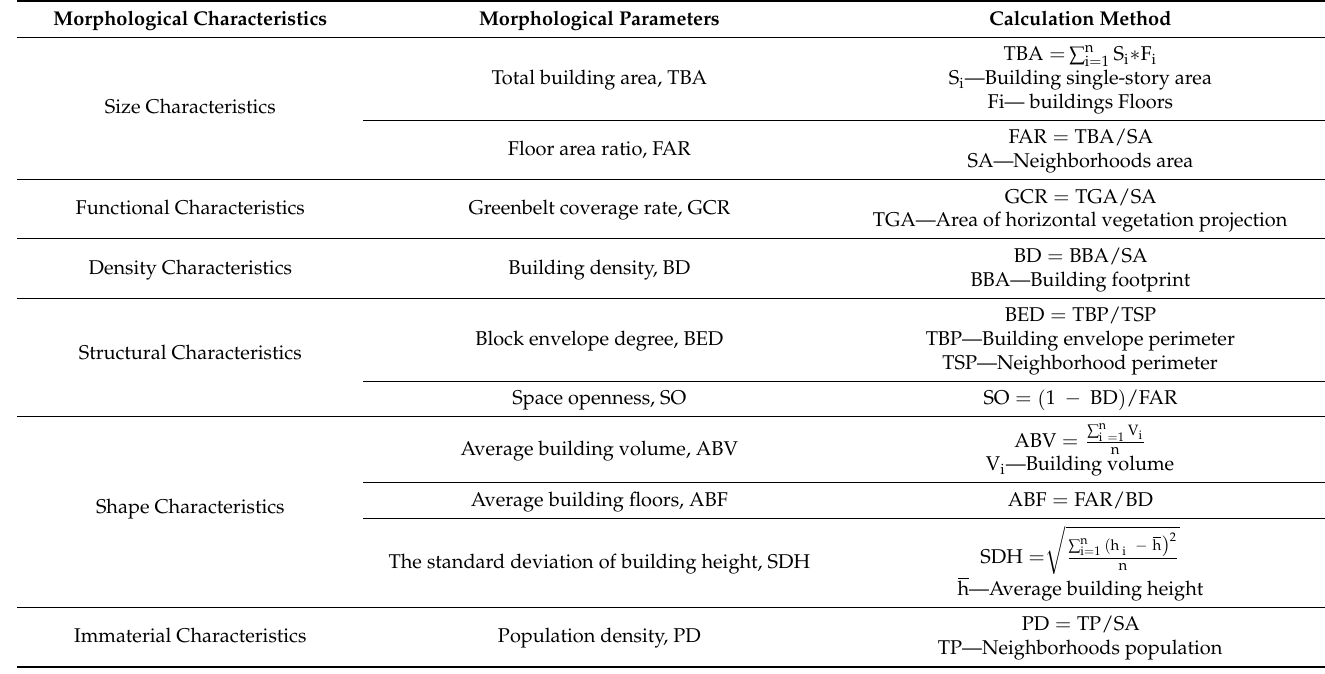
Table 2. Selection of characteristic morphological parameters of